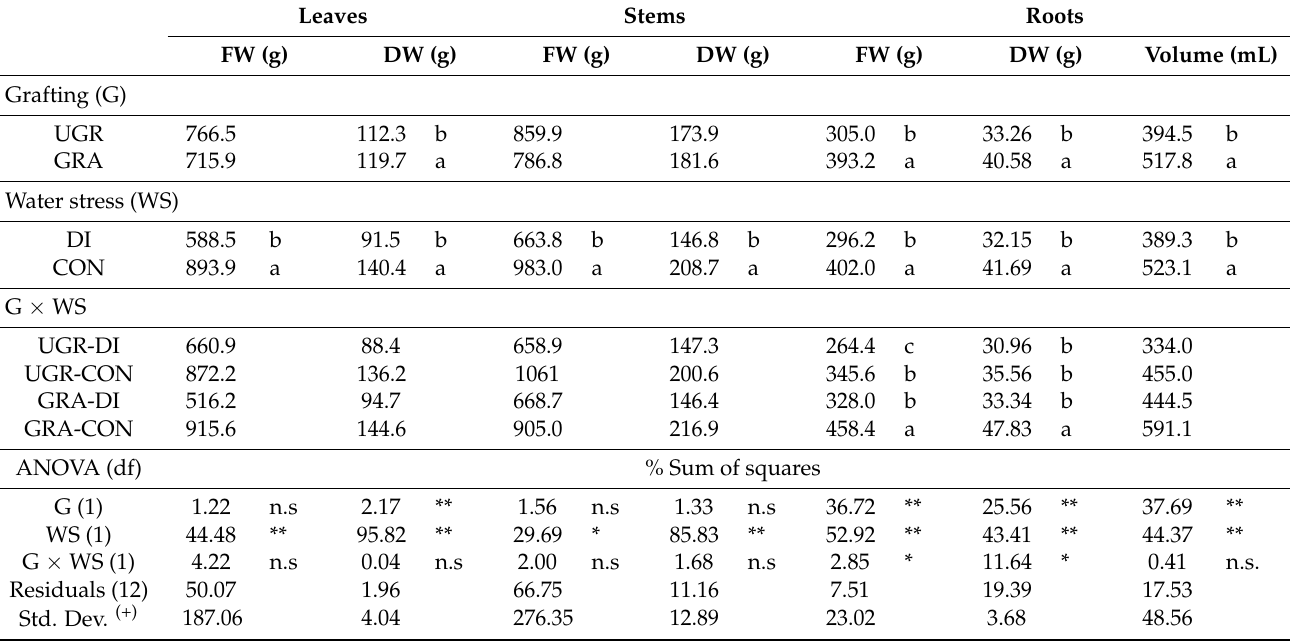
Table 3. Effect of grafting and water stress on the fresh weight (FW) and dry weight (DW) of leaves, stems and roots, and root volume.